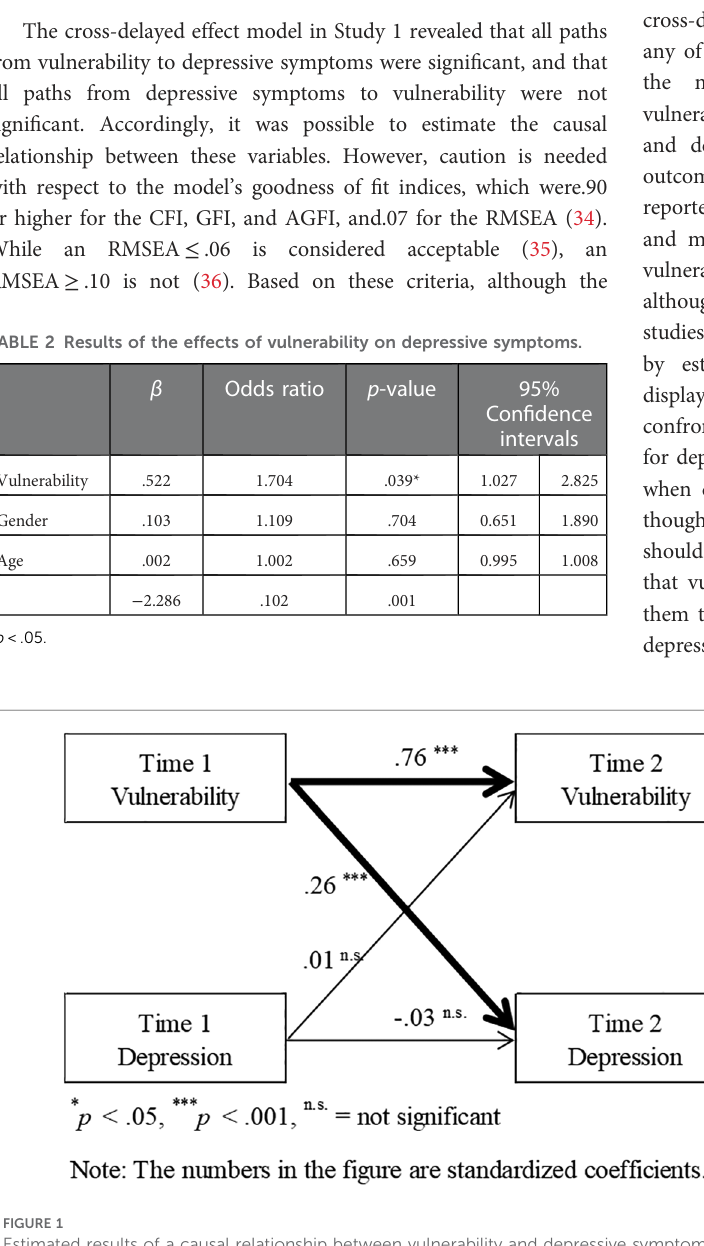
FIGURE 1 Estimated results of a causal relationship between vulnerability and depressive